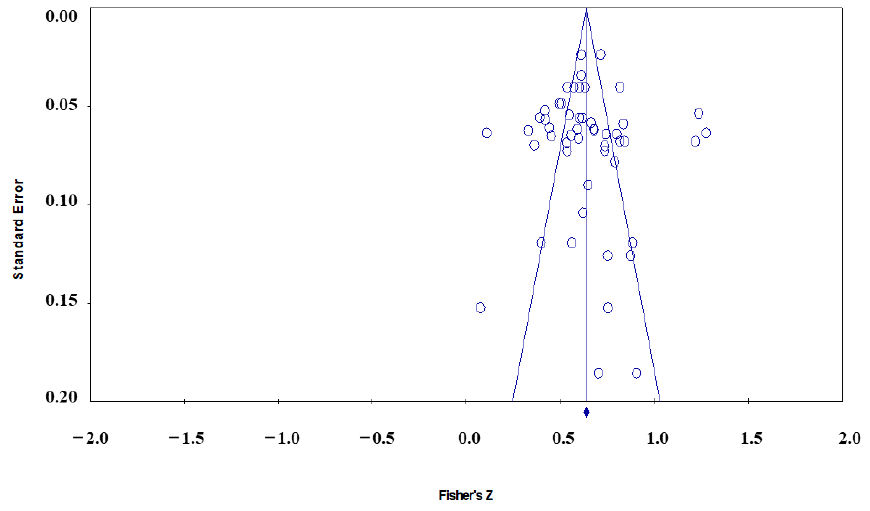
Figure 3. The funnel plot of the whole sample.